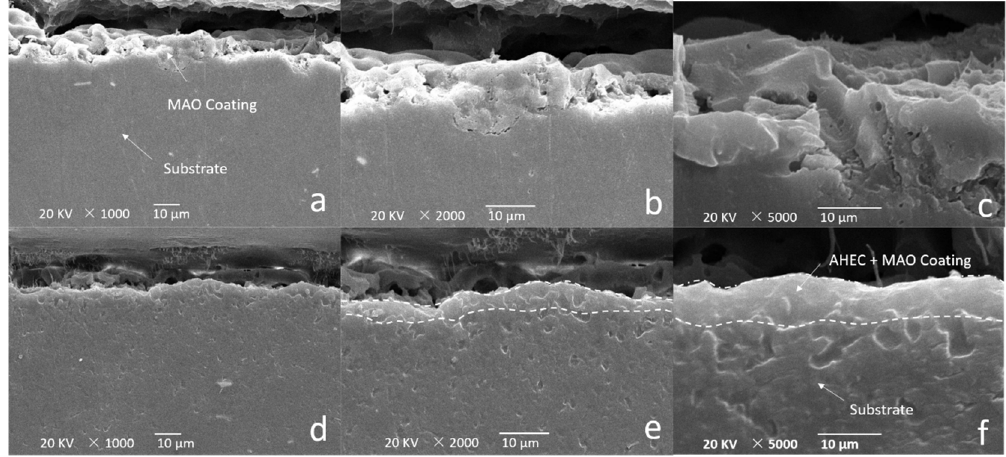
Figure 2. Cross-sectional morphologies of ( a – c ), MAO + AZ31 and ( d – f ) AHEC + MAO + AZ31. Table 1. Coating thickness of AZ31 substrate (mean ± standard deviation). Table 1. Coating thickness of AZ31 substrate (mean ± standard